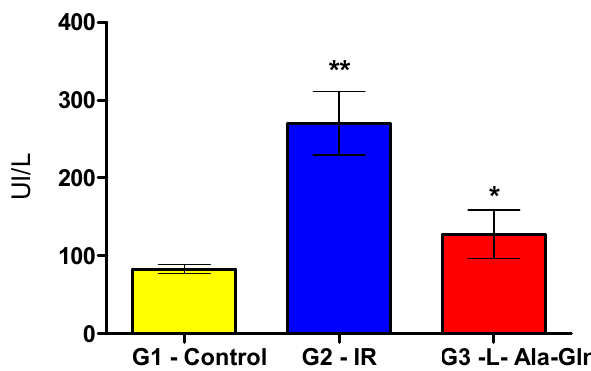
FIGURE 2 - Aminotransferase (ALT) concentrations (units/Liter) in blood serum of G-1 (Control), G-2 (Ischemia/reperfusion) and G-3 (Ischemia/reperfusion+L-Ala-Gln) rats. Bars represent mean ± SD of G-1 (yellow bars), G-2 (blue bars) and G-3 (red bars) groups at the end of the reperfusion. G-3 group is significantly different from control group by ANOVA test. * P< 0.05 compared with control group.